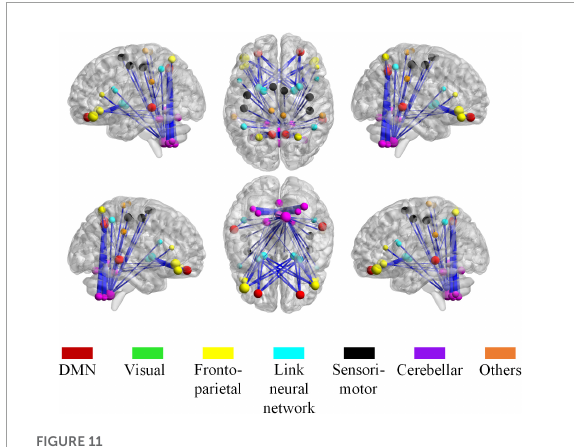
FIGURE11 The most discriminative connections and brain regions in the whole brain view. The size of a node, calculated from the total weight of all clusters that containing the node, indicates the importance of the node during the classification. The thickness of the edge represents the classification weight of the cluster that connects the edge.